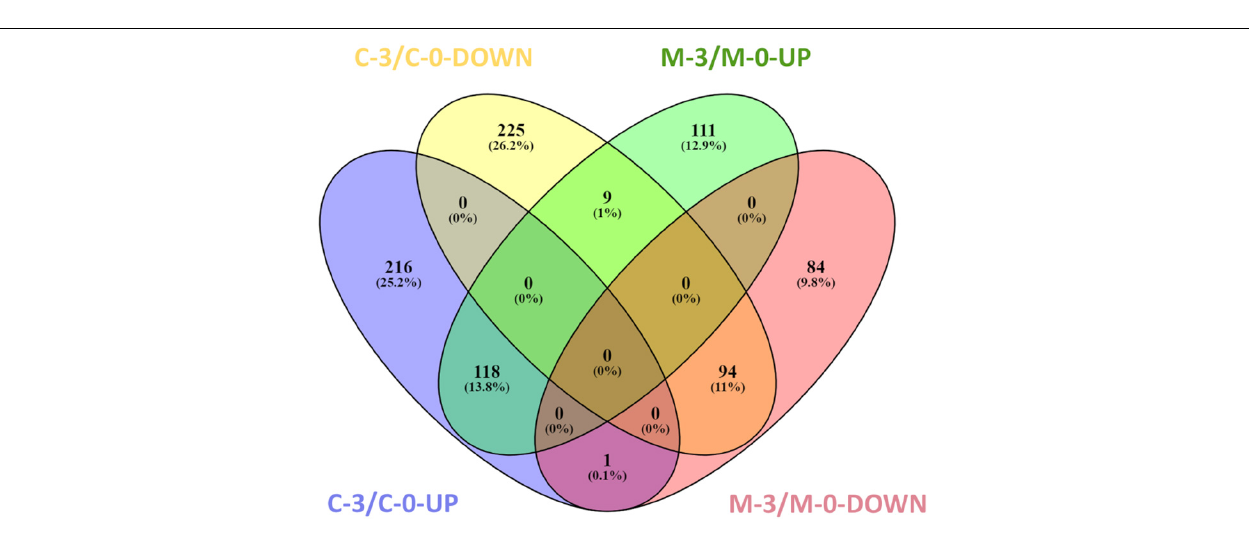
FIGURE 4 | Venn diagram representing the number of up and downregulated genes in X. fastidiosa under copper stress. M-3/M-0: pairwise comparison between the M-3 ( Xf-mqsR + CuSO4) and M-0 ( Xf-mqsR ) libraries. C-3/C-0: pairwise comparison between the C-3 ( Xf -EV + CuSO4) and C-0 ( Xf -EV) libraries. UP: upregulated genes; DOWN: downregulated